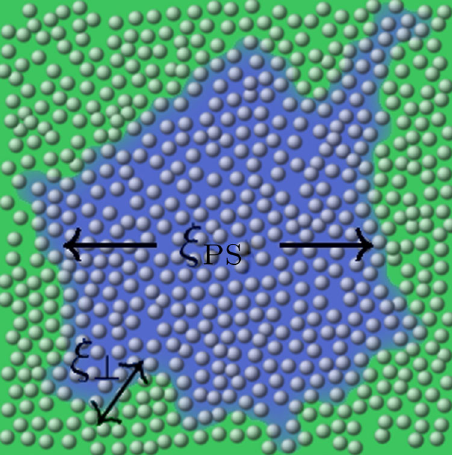
FIG. 1. Illustration of a two-dimensional cut of a cooperative rearranging region: the linear spatial extent is of the order ξ whereas the external shape is rough and fluctuating over the length scale ξ ⊥ .